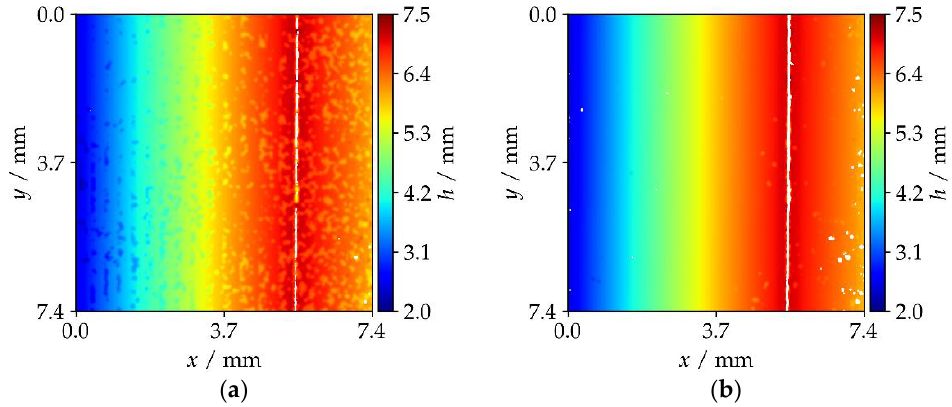
Figure 10. Masked height map ℎ of the combined tooth data using ( a ) maximum filter: combination errors due to discrete and hence imprecise shape-from-focus data; ( b ) Gaussian filter: almost no combination errors occur onto the Gaussian fit output.